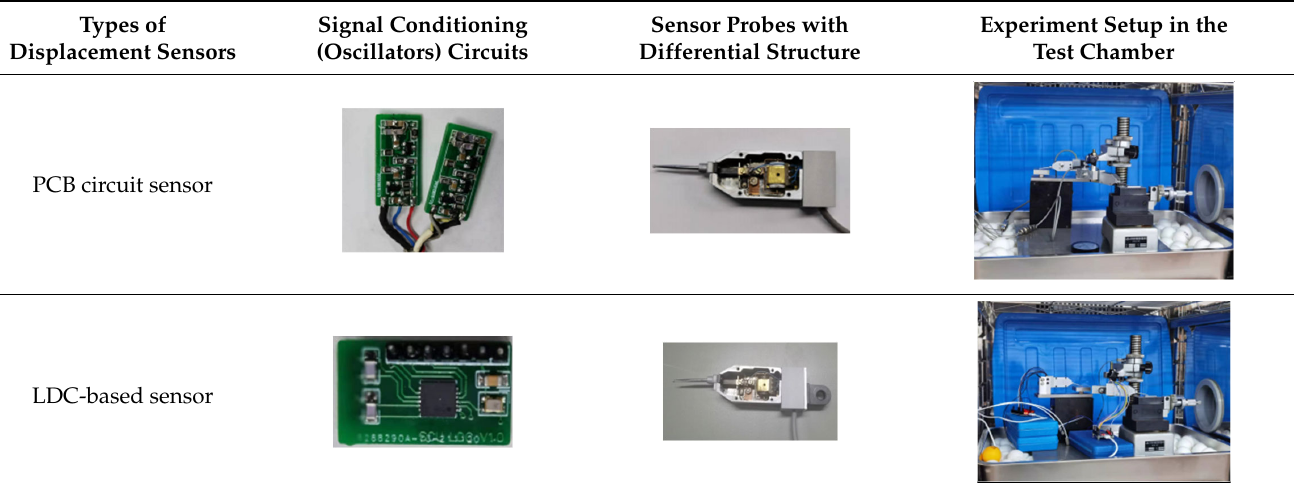
Table 3. Prototype of DIFOD sensors’ structure, signal conditioning devices and experimental setup.